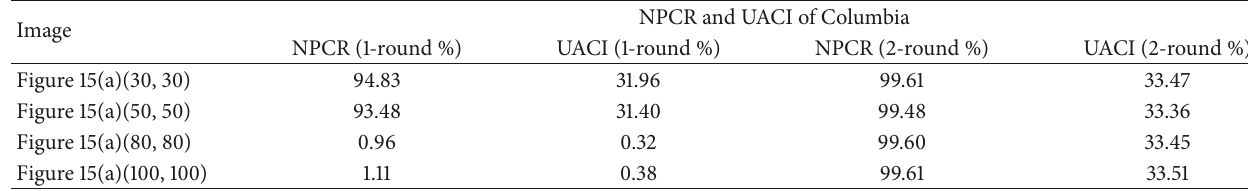
Table 12: NPCR and UACI between cipher-images with slightly different plain-images.